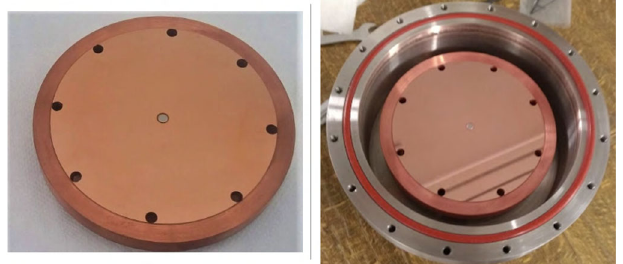
FIG. 2. Left: image of the Y thin film deposited on Cu center flange. Right: the flange inside the vacuum chamber used for the transport to CTF.